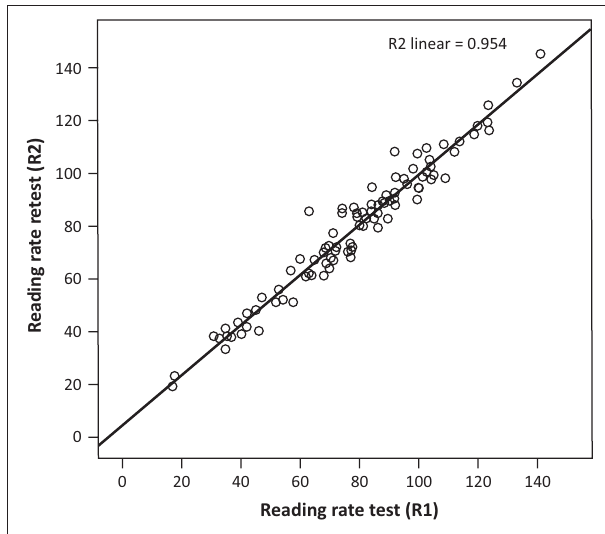
FIGURE 4: Scatter plot showing paediatric rate of reading (PRR) test (R1) and retest (R2) in correct words per minute at first and second testing session, 1 week apart, using the PRR chart. R1 and R2 measurements show a strong correlation ( r =